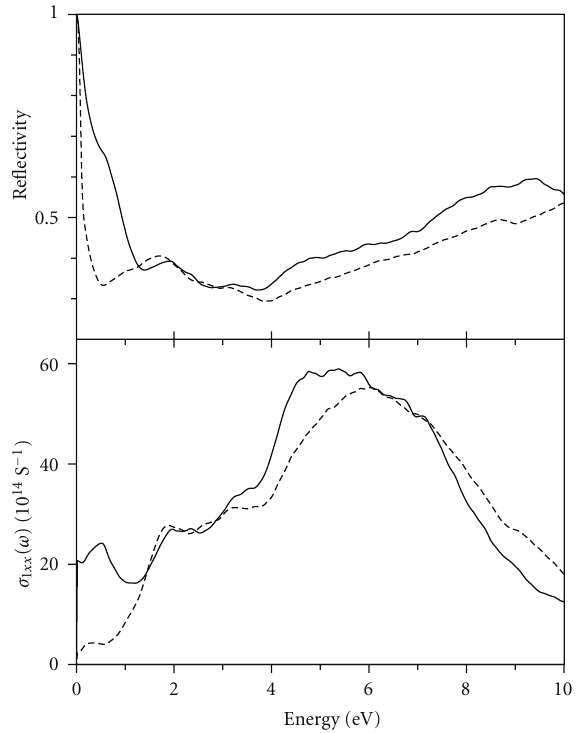
Figure 84: Calculated optical reflectivity R ( ω ) and conductivity σ ( ω ) in Sm 4 As 3 with one (dashed line) and all four Sm ions in the trivalent state (full line)